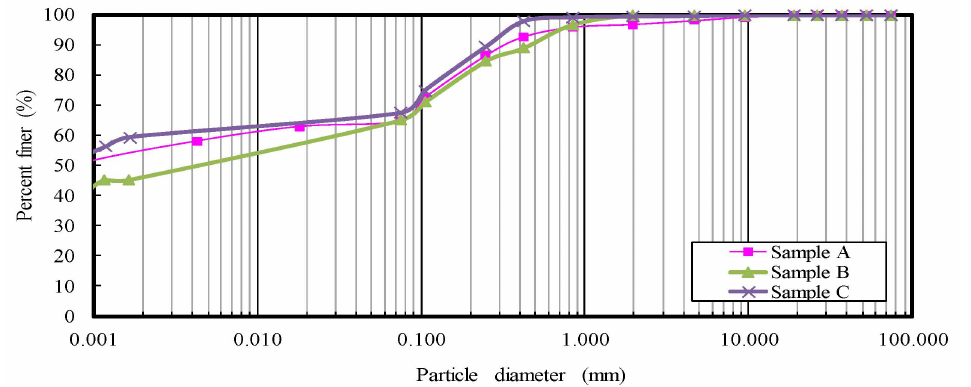
Figure 2. Grain size distribution of Kumamoto clay.